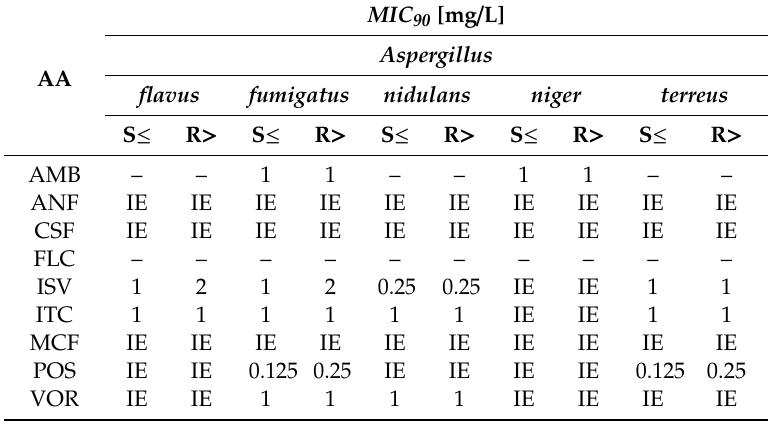
Table 4. The susceptibilities of antifungal drugs against selected Aspergillus species are expressed as minimal inhibitory concentrations inhibiting the growth of 90% of the microorganism ( MIC 90 ) [mg / L]. AA = antifungal agent, IE = insu ffi cient